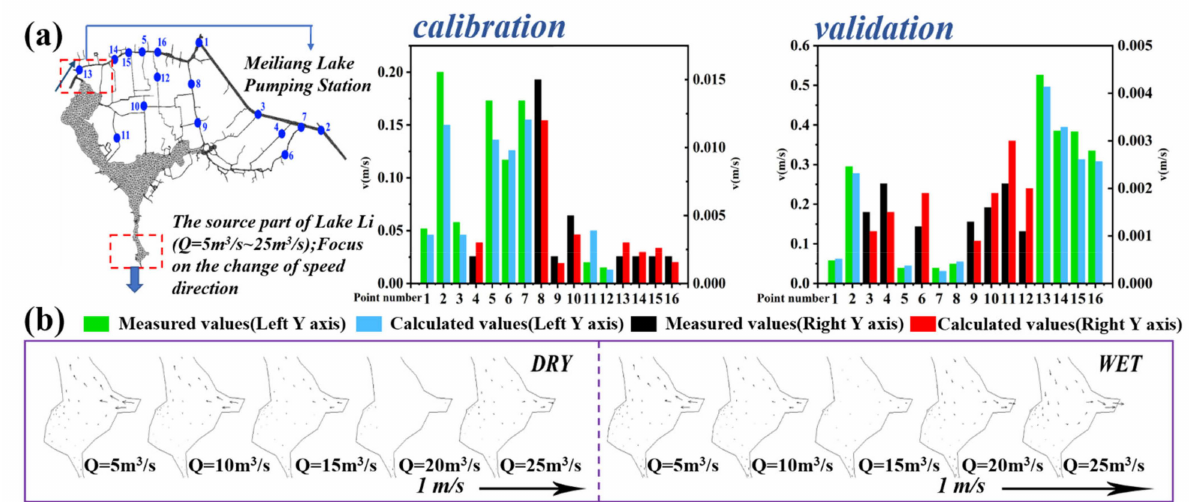
Figure 4. ( a ) River network model verification and calibration; ( b ) the flow direction of Xiushui River under different water diversion